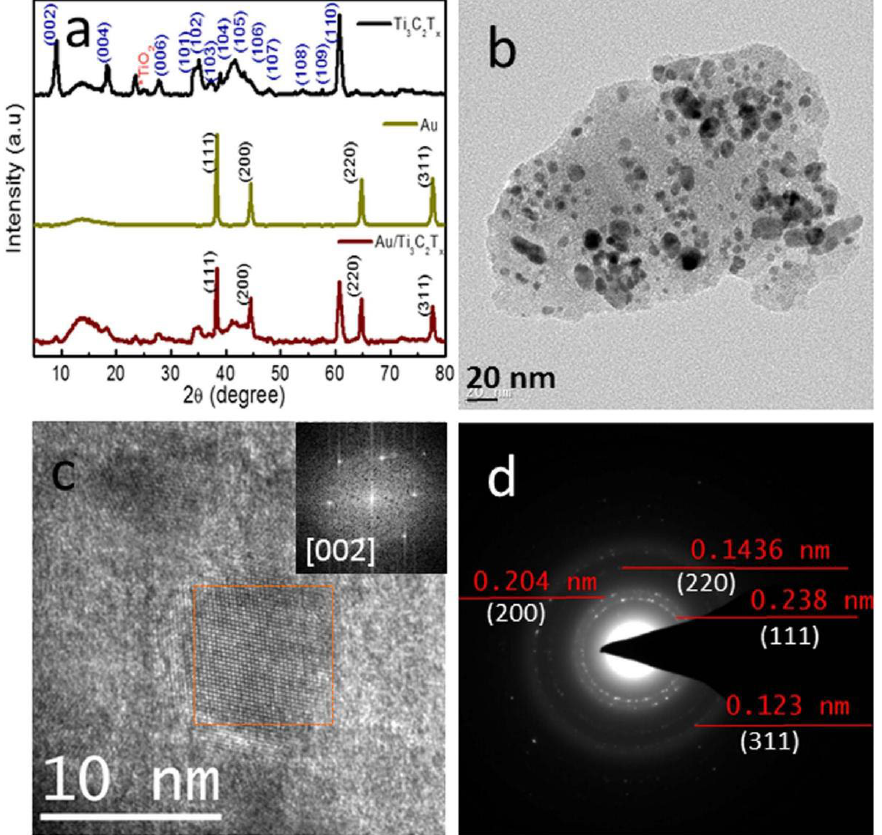
Figure 2. ( a ) Powder X-ray diffraction pattern of Ti 3 C 2 T x MXene, Au nanoparticles and Au/Mxene nanocomposite ( b ) TEM and ( c ) HRTEM images of Au/MXene nanocomposite. Inset of ( c ) shows the FFT pattern taken from the marked area. ( d ) SAED pattern corresponding to the marked area in ( c ). Reprinted with permission from [62]. Copyright 2016 Springer